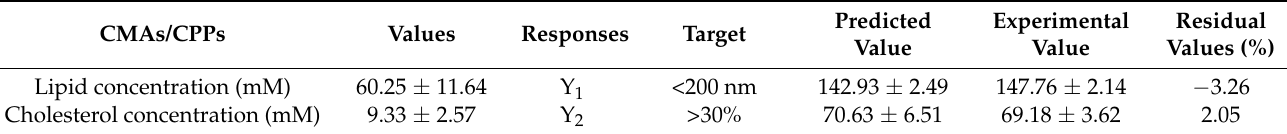
Table 3. Optimized formulation